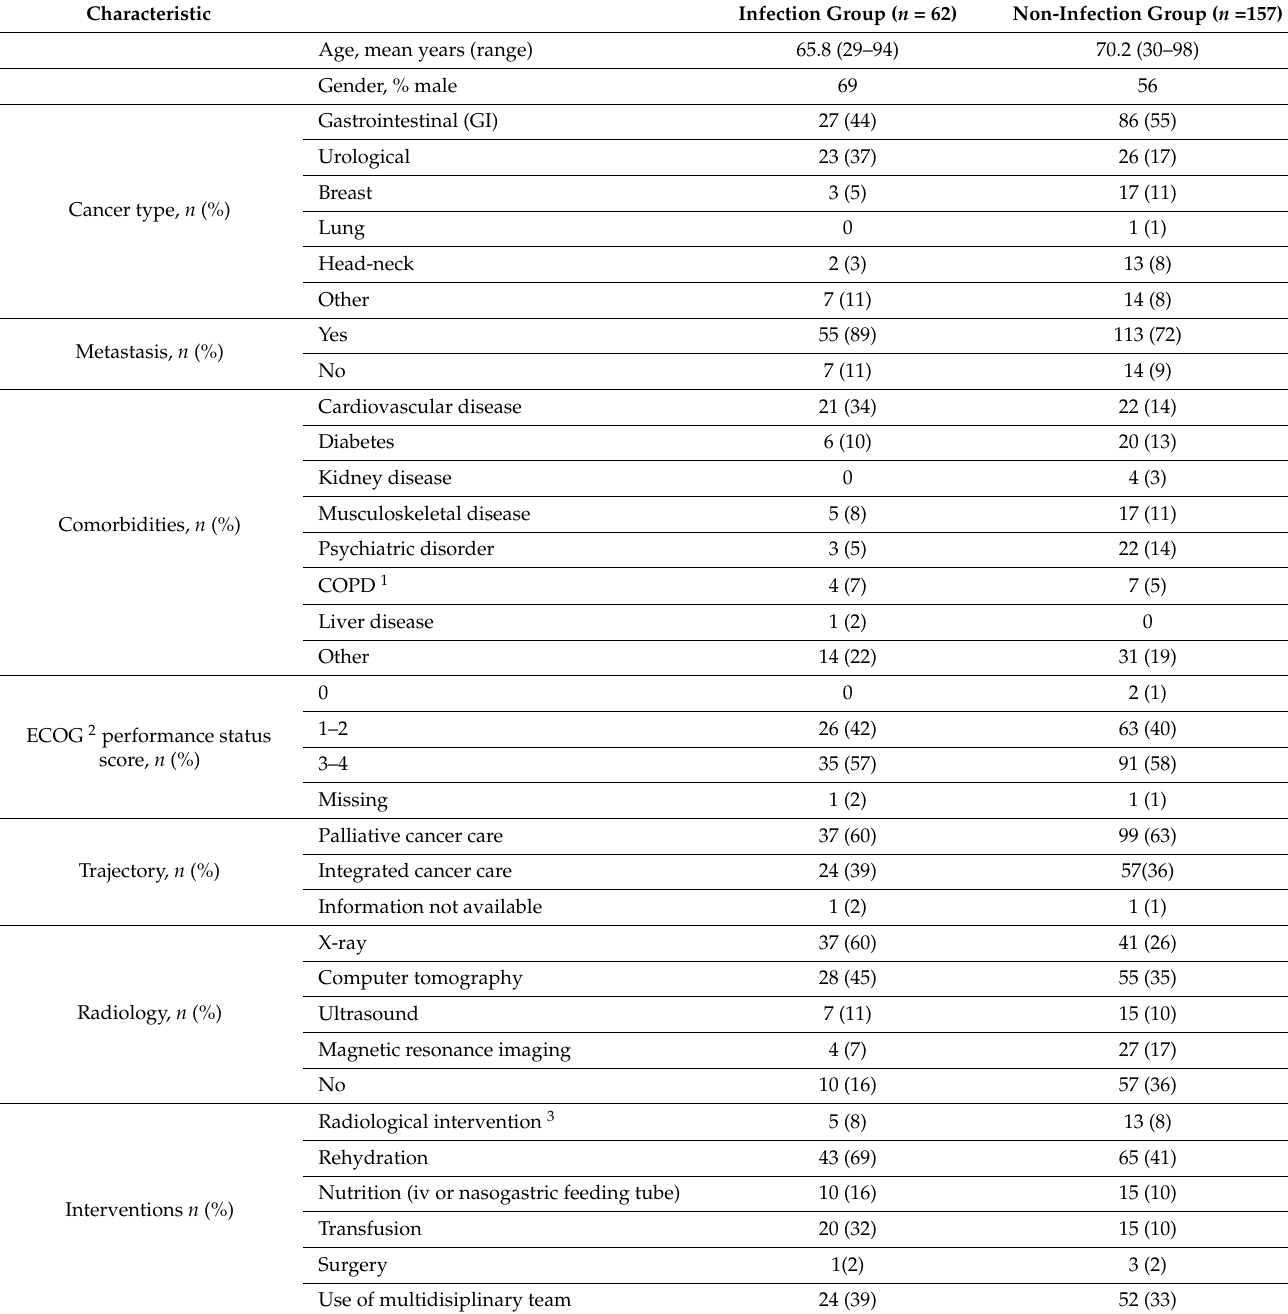
Table 1. Demographic and baseline clinical characteristics at